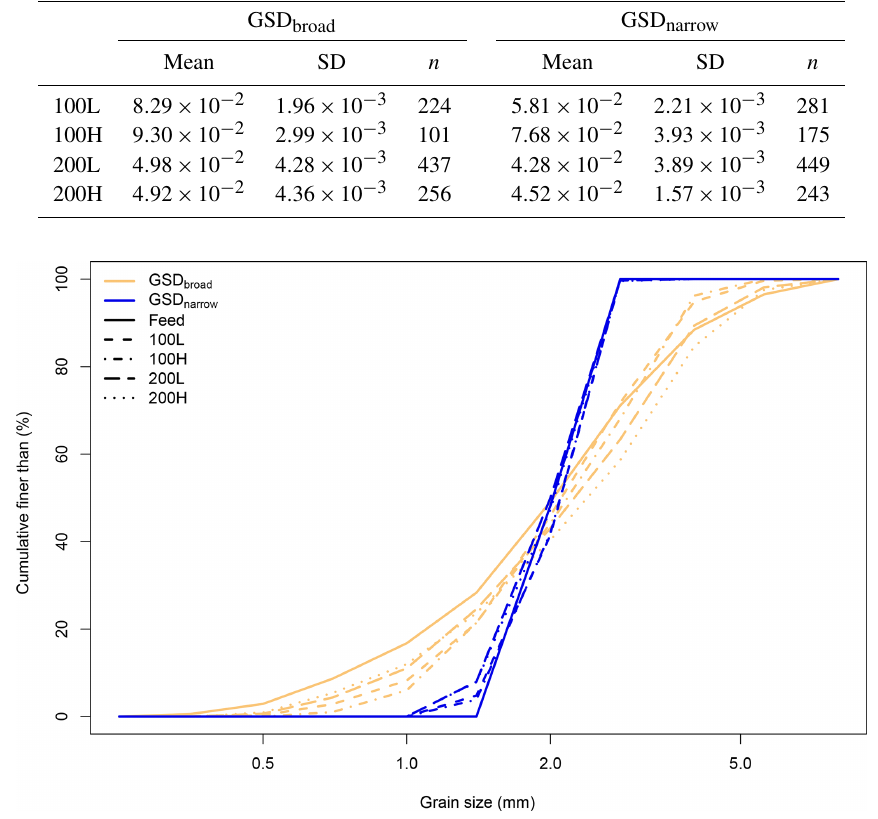
Table 1. Mean slope values and standard deviations, for the eight experiments reported here.